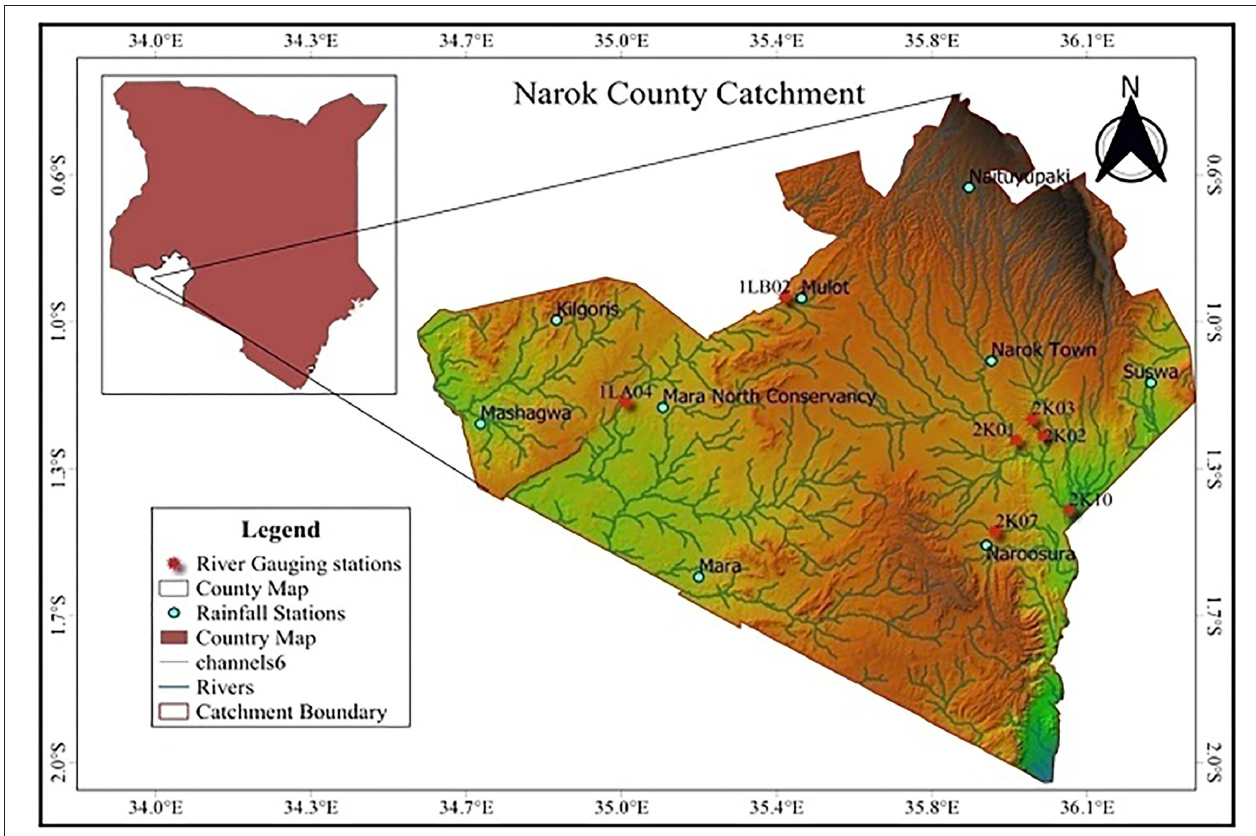
FIGURE 1 | Location of Narok County catchment with